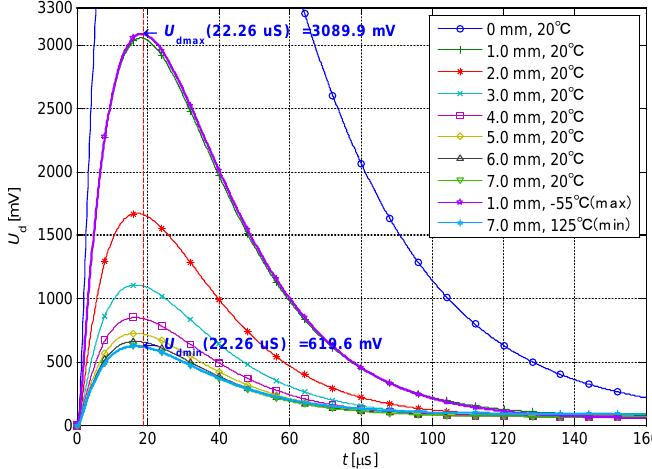
Figure 8. Response waveforms of the differential structured IPS.